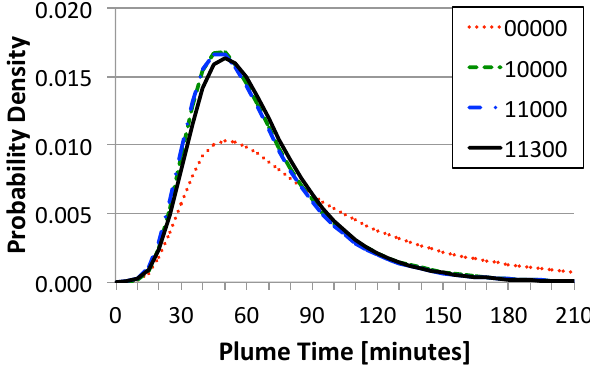
Figure 4. Probability density functions of plume time (Eq. 10) for Fig. 4. Probability density functions of plume time (Eq. (10)) for different filter 1519 different filter configurations (Table 2) used in data screening and configurations (Table 2) used in data screening and selection for generating C e 1520 selection for generating C e scatter scatterplots. 1521 1522